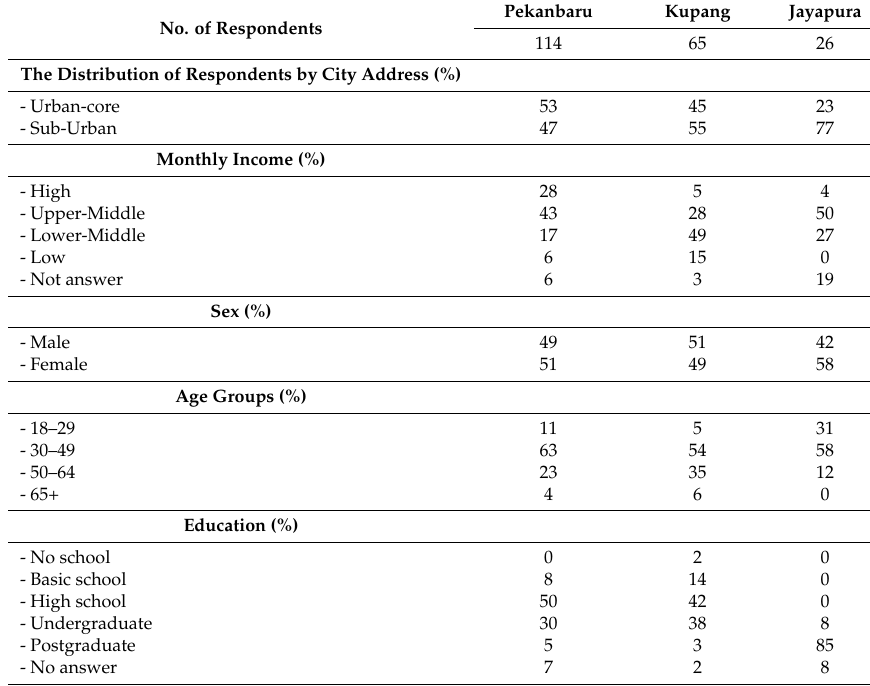
Table A1. Demographics of respondents who participated in the user